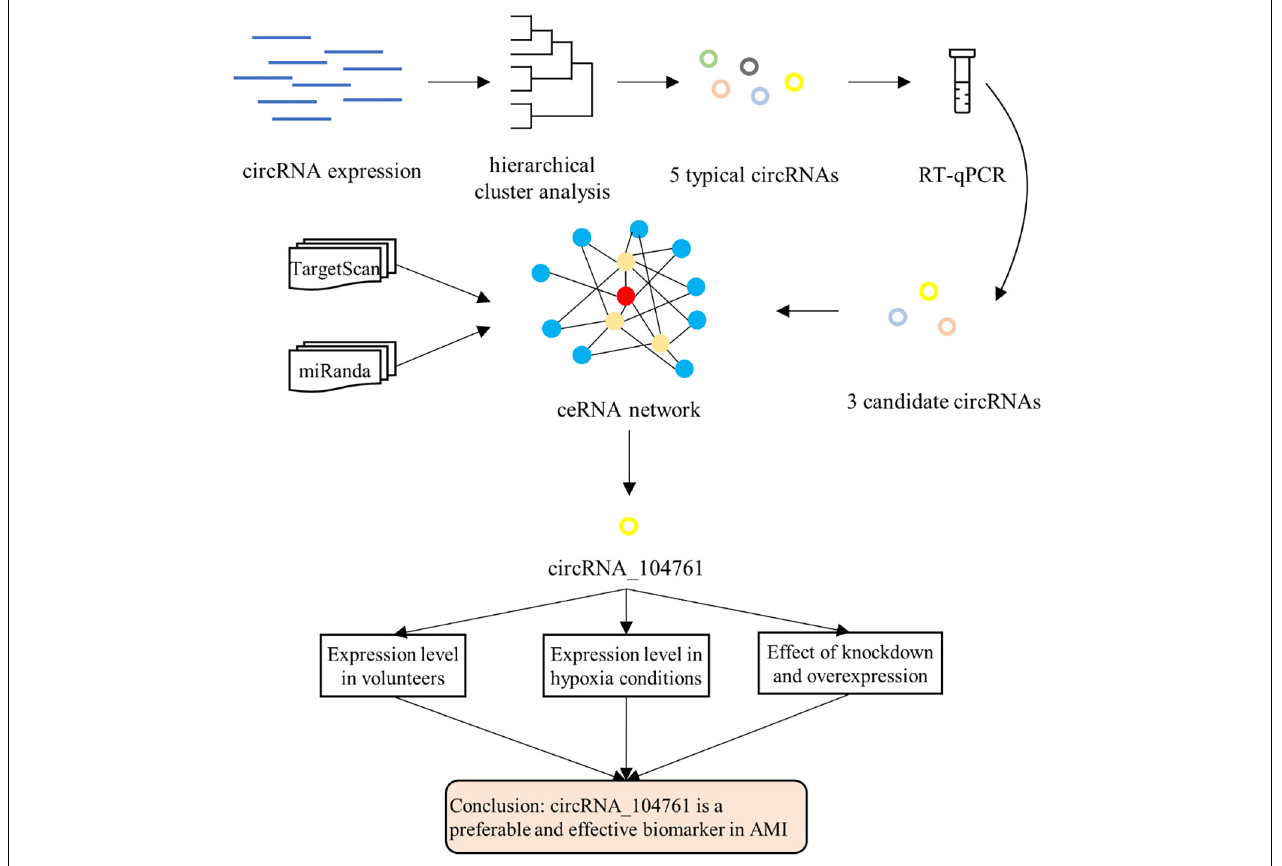
FIGURE 1 | Overall